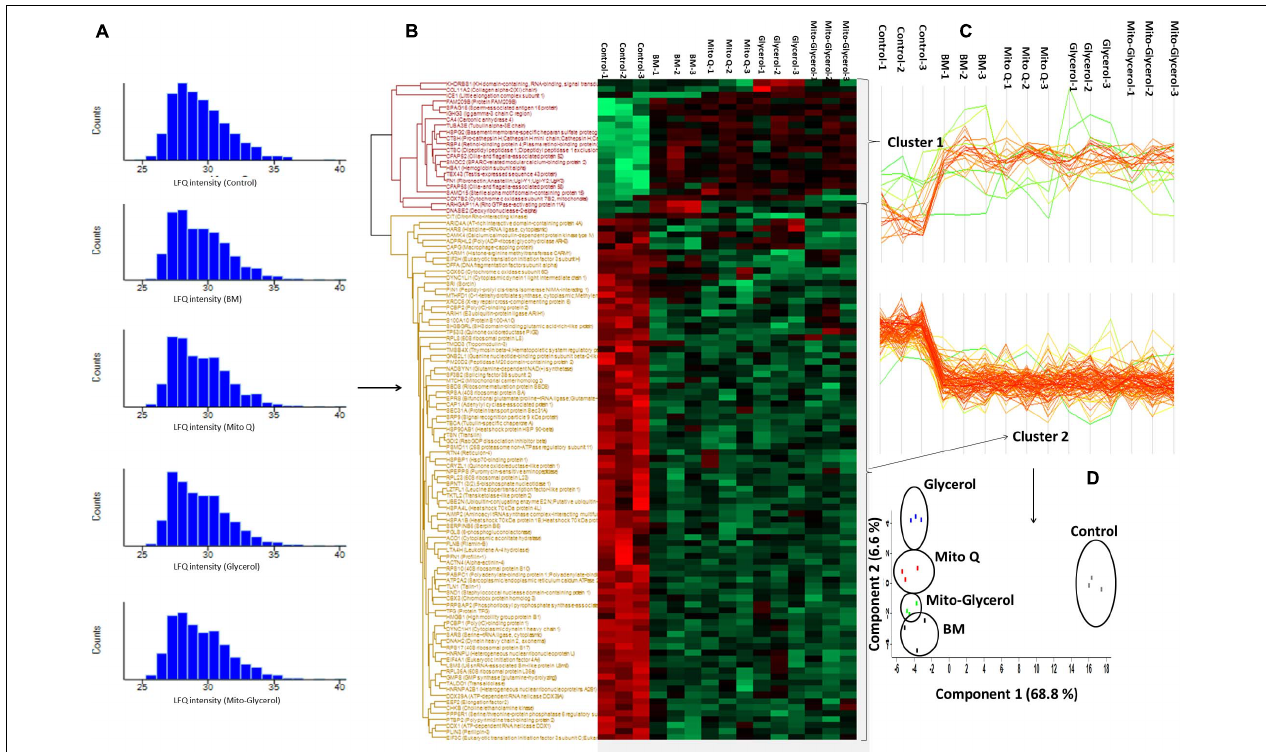
FIGURE 4 | (A) Histograms of the label-free quantification (LFQ) intensities of the identified proteins in the control and treatment groups showing a mostly normally distributed pattern. (B) Heat map of significant changes in protein levels in the spermatozoa before and after vitrification. The relative abundance level of each protein is shown on a color scale from green (lowest) to red (highest). (C) Profile plots of two distinguished clusters in a heat map ( different colors of dendrograms) showing distinct behavior from the five states (one control and four treatments). (D) Principal component analysis of the differentially expressed proteins showing a well-separated cluster of fresh and vitrified spermatozoa groups. Each square represents one sample, and three replicates of each group are enclosed in circles .